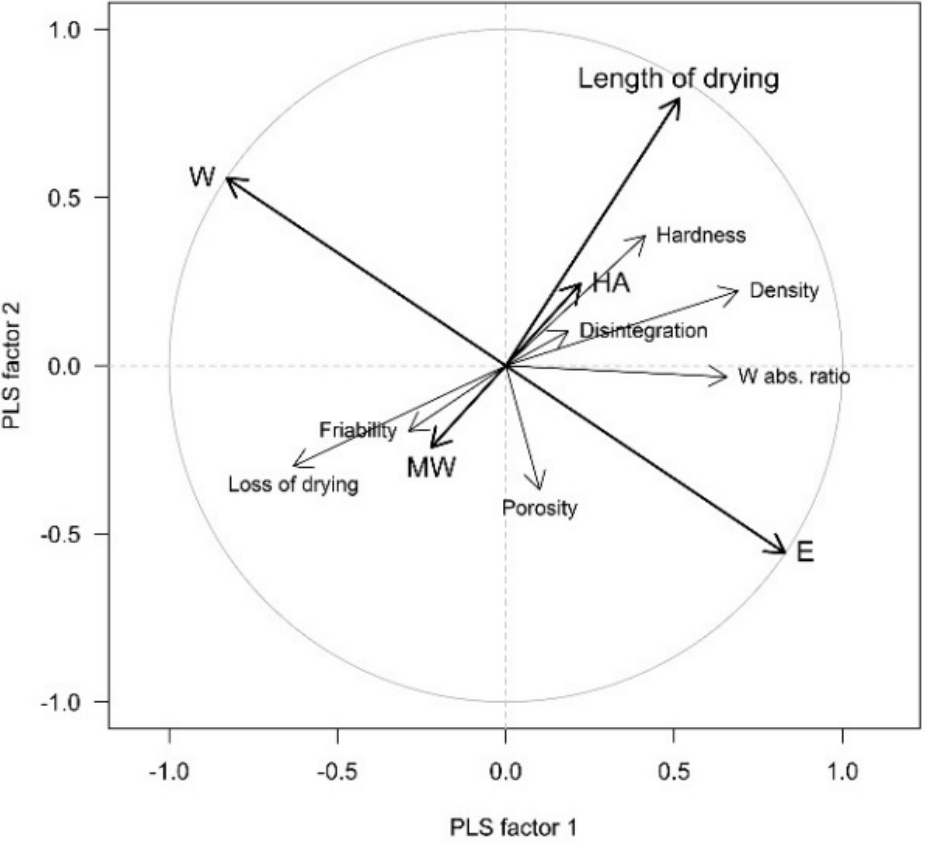
Figure 1. Correlation loadings plot (PLS); arrows for input variables (preparation parameters) depicted by bold lines; arrows for output variables (physico-mechanical parameters) represented by thin lines.